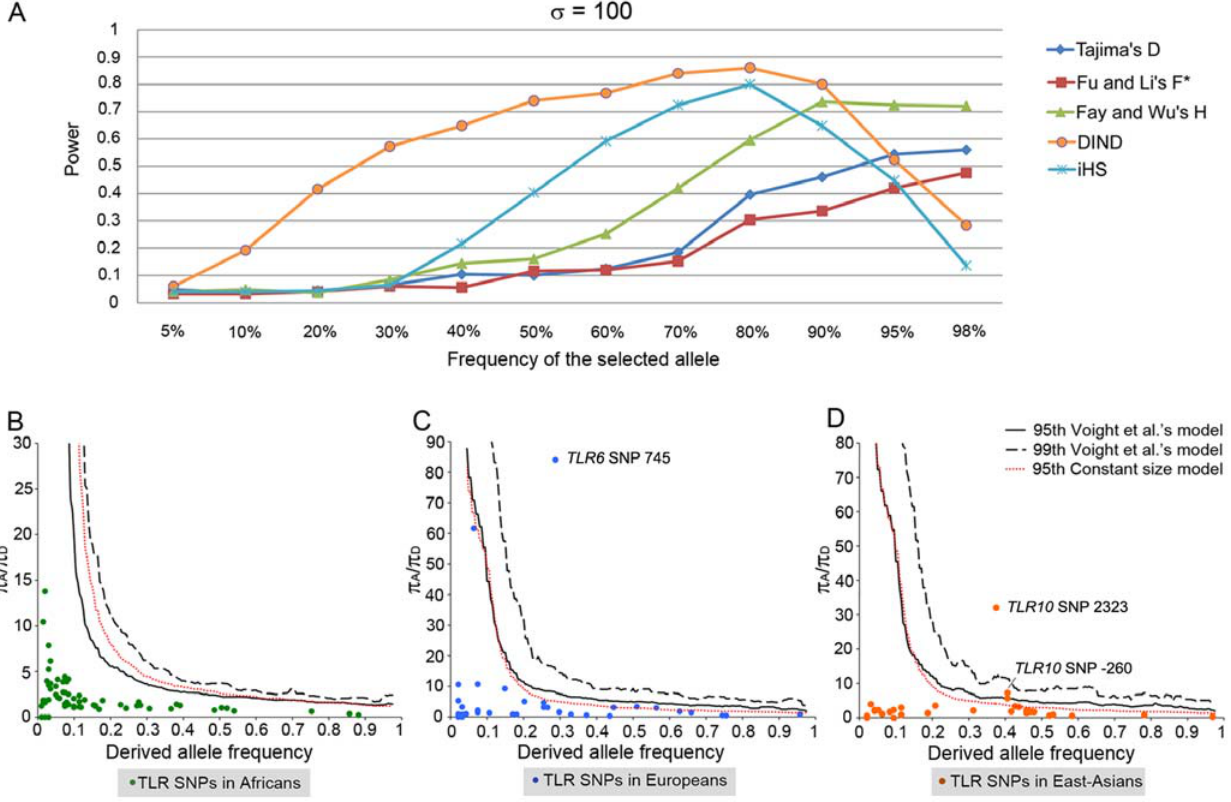
Figure 5. Signatures of positive selection targeting the TLR10 - TLR1 - TLR6 gene cluster. (A) Power of the DIND test with respect to other statistics as a function of the frequency of the selected allele when the selection coefficient (S=2Ns) is set to be 100. DIND test in (B) Africans, (C) Europeans and (D) East-Asians. P values were obtained by comparing the i p A / i p D values for the TLRs against the expected i p A / i p D values obtained from 10,000 simulations considering both a model of constant population size and the demographic model of Voight et al. ’s [55] (Materials and Methods).